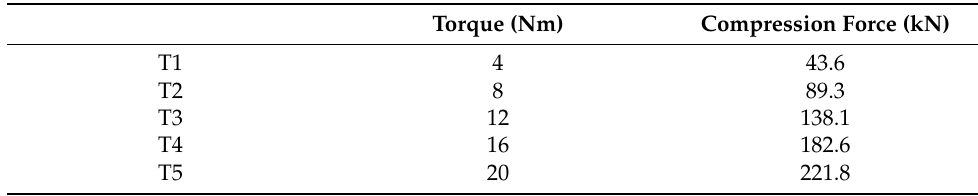
Table 5. Cell Compression Values.